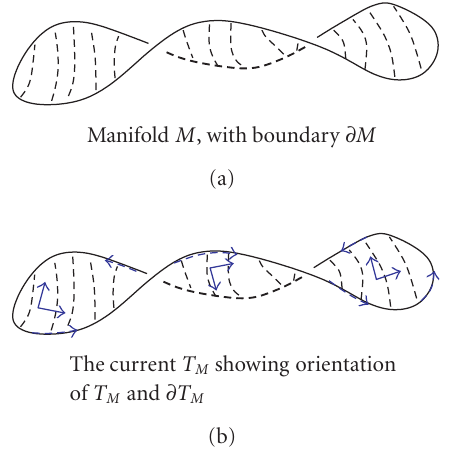
Figure A.1. Example 2-current T M . Notice that ∂T M = T ∂M . The orientation on the boundary ∂M is simply that inherited from the orientation on M